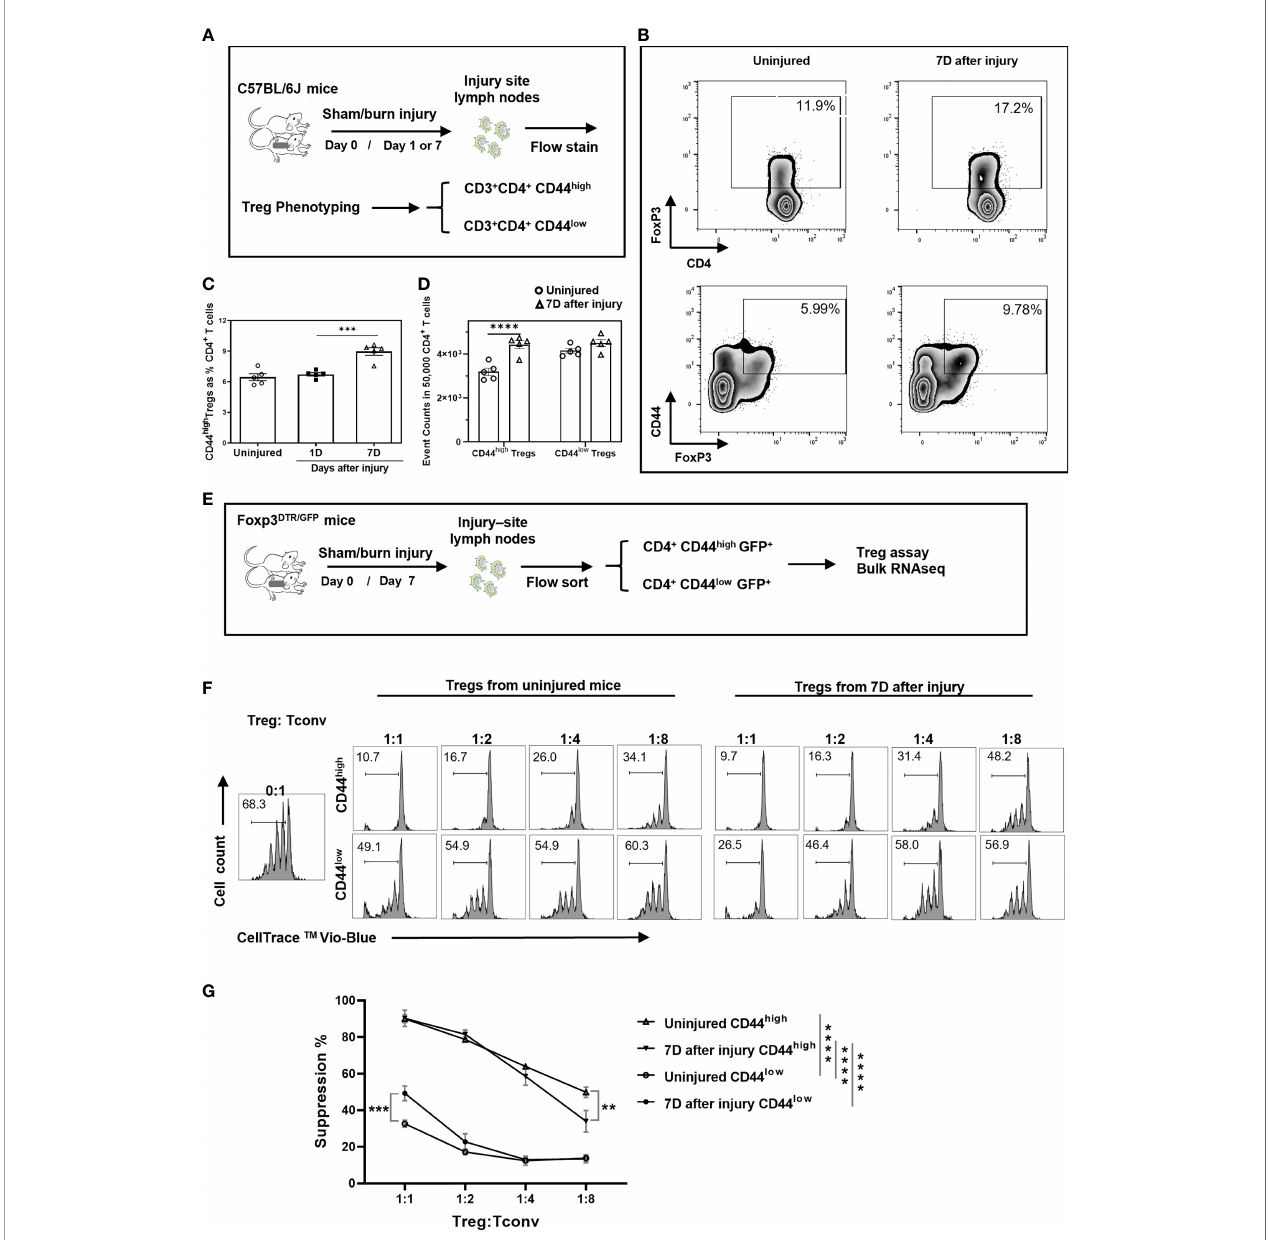
FIGURE 1 | Burn trauma induces the expansion of CD44 high Tregs in injury-site draining lymph nodes that more potently suppress T cell proliferation than CD44 low Tregs. (A) Experimental scheme for mouse Treg phenotyping by fl ow cytometry; (B) Representative fl ow cytometry contour plots illustrating Tregs and CD44 high Tregs in CD4 + T cells in injured and uninjured mice. (C) CD44 high Tregs are signi fi cantly increased in injury-site draining lymph nodes at 7 days ( D ), but not at 1 day ( ■ ) after injury compared to uninjured controls ( ○ ). Data are presented as mean ± standard error of the mean (SEM) and analyzed by one-way analysis of variance (ANOVA), P=0.0001. Signi fi cant comparisons by Dunnett ’ s multiple comparisons test are denoted by *** (uninjured versus 7 days after burn), P=0.0002. (D) CD44 high and CD44 low Treg cell events in equal-sampled CD4 + T cells. Flow cytometry data represent two independent experiments (n=5 per group). Data were analyzed by two-way ANOVA, interaction P=0.0117. Signi fi cant comparisons by Sidak ’ s multiple comparisons test are denoted by **** (uninjured control versus 7 days after injury in CD44 high Tregs), P<0.0001. (E) Experimental scheme for Treg functional assay and bulk RNA sequencing. (F) CD4 + CD25 - T cells (Tconv) FACS sorted from lymph nodes were labeled with CellTrace Violet and co-cultured with FACS sorted CD44 high and CD44 low Tregs from uninjured or injured Foxp3 DTR mice at the indicated cell concentration ratios. CellTrace Violet dilution was used to calculate percentage of proliferating Tconv cells after 4 days of co-culture with anti-CD3/CD28 antibody-coated T cell activation beads. Representative Treg suppression plots are shown. (G) Plots summarizing Treg suppressive activity. Error bars represent the mean ± SEM of n = 3 replicate wells. Data were analyzed by two-way ANOVA, interaction P<0.0001. Signi fi cant comparisons by Dunnett ’ s multiple comparisons test are indicated by **P<0.01, ***P<0.001 and